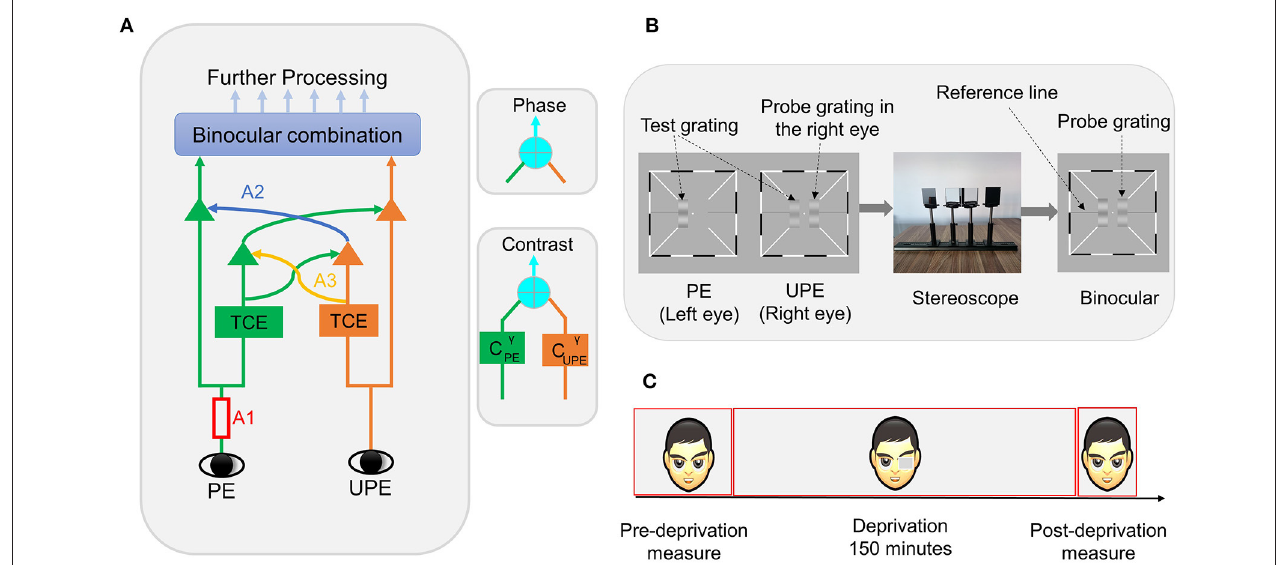
FIGURE 1 | (A) Schematic diagram of the binocular combination of the MCM. PE represents the patched eye, and UPE represents the unpatched eye; A1 represents the monocular signal, which first goes through double interocular contrast-gain control; TCE represents total contrast energy; A2 represents the exertion of gain control by each eye onto the other eye’s signal in proportion to its signal contrast energy, and A3 represents the exertion of gain control by each eye over that of the other eye. The phase and contrast of the cyclopean images are computed in separate pathways. (B) Binocular phase and contrast combination test. Three sine-wave gratings are presented dichoptically. The two test gratings are fused into one standard grating by a stereoscope. Subjects are tasked with adjusting both the phase and contrast of the grating to match those of the standard grating. (C) Experimental design. Subjects perform phase and contrast co-measurement tasks at different